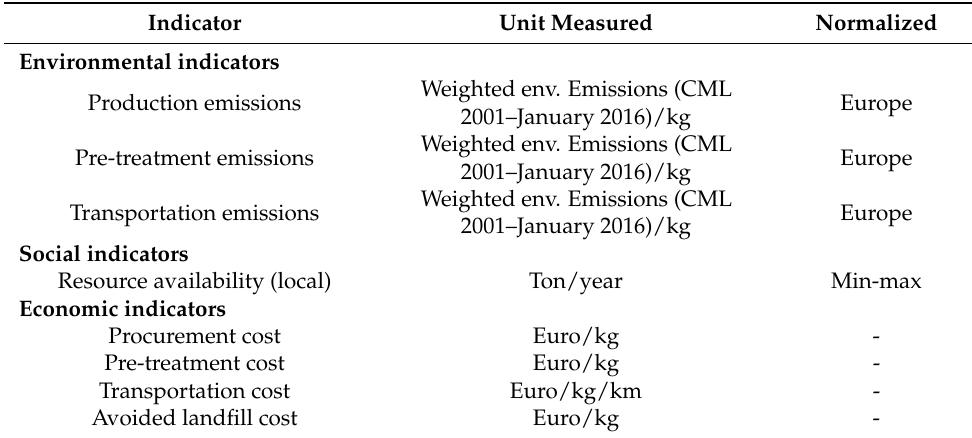
Table 7. Most relevant economic, environmental, and social indicators. Indicator Unit Measured